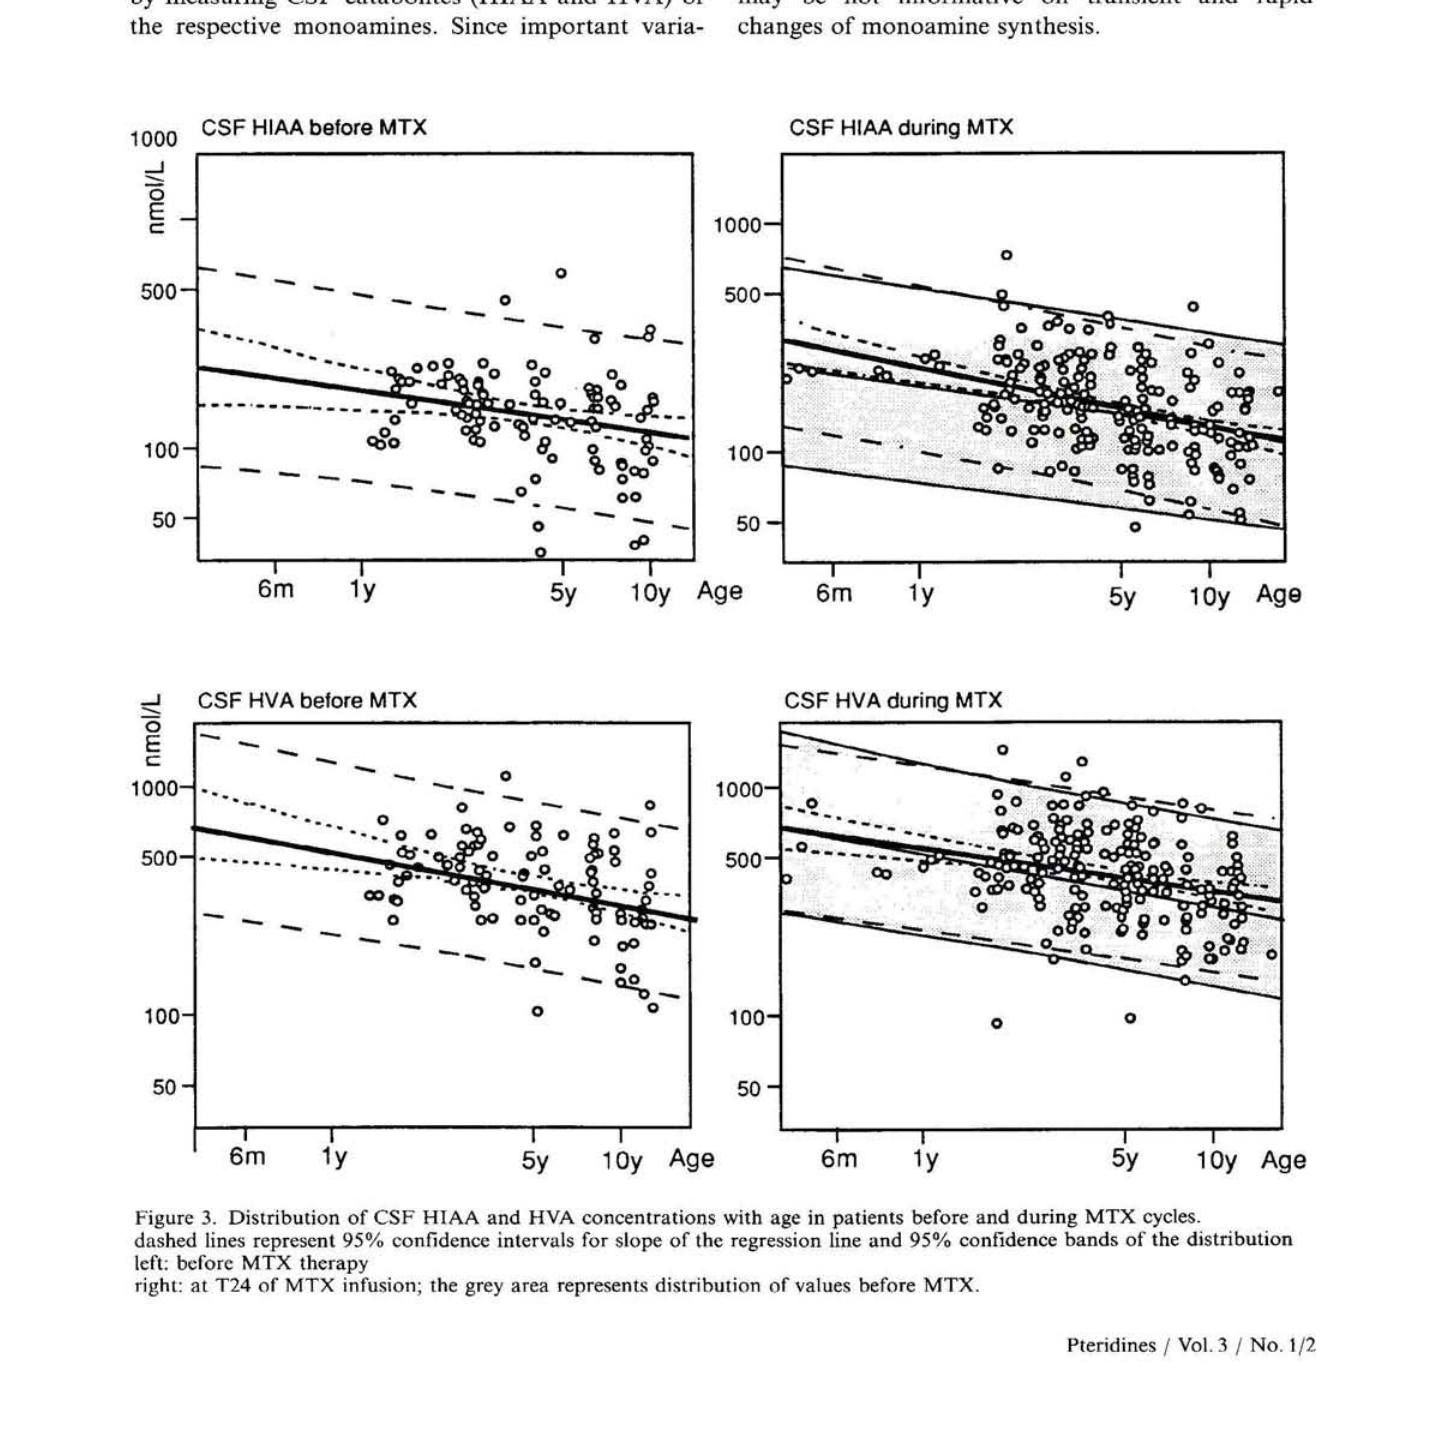
Figure 3. Distribution of CSF HIAA and HVA concentrations with age in patients before and during MTX cycles, dashed lines represent 95% confidence intervals for slope of the regression line and 95% confidence bands of the distribution left: before MTX therapy right: at T24 of MTX infusion; the grey area represents distribution of values before MTX.